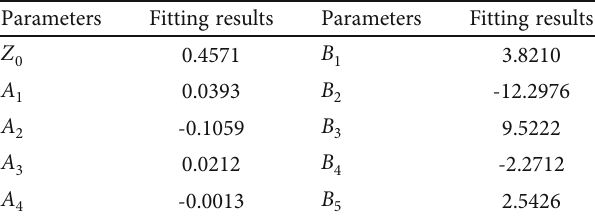
Table 6: Fitting results of Rational2D function.